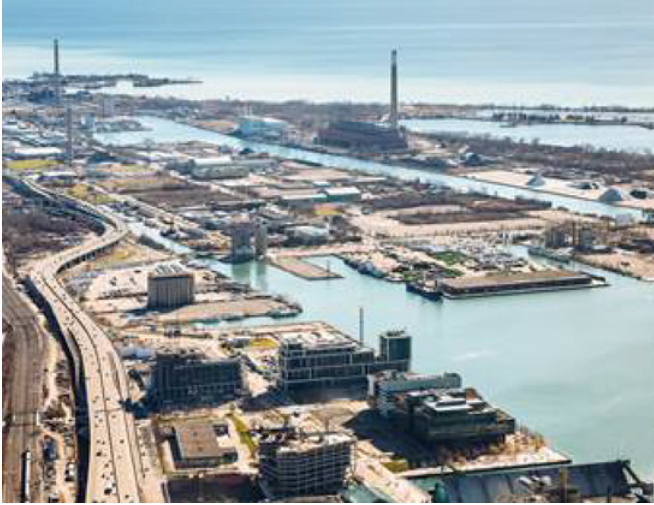
Figure 4 An absence of visual meaning; or is context the visual meaning? Source: (Sidewalk Labs, 2017, p.13). Credit: Sidewalk Labs.